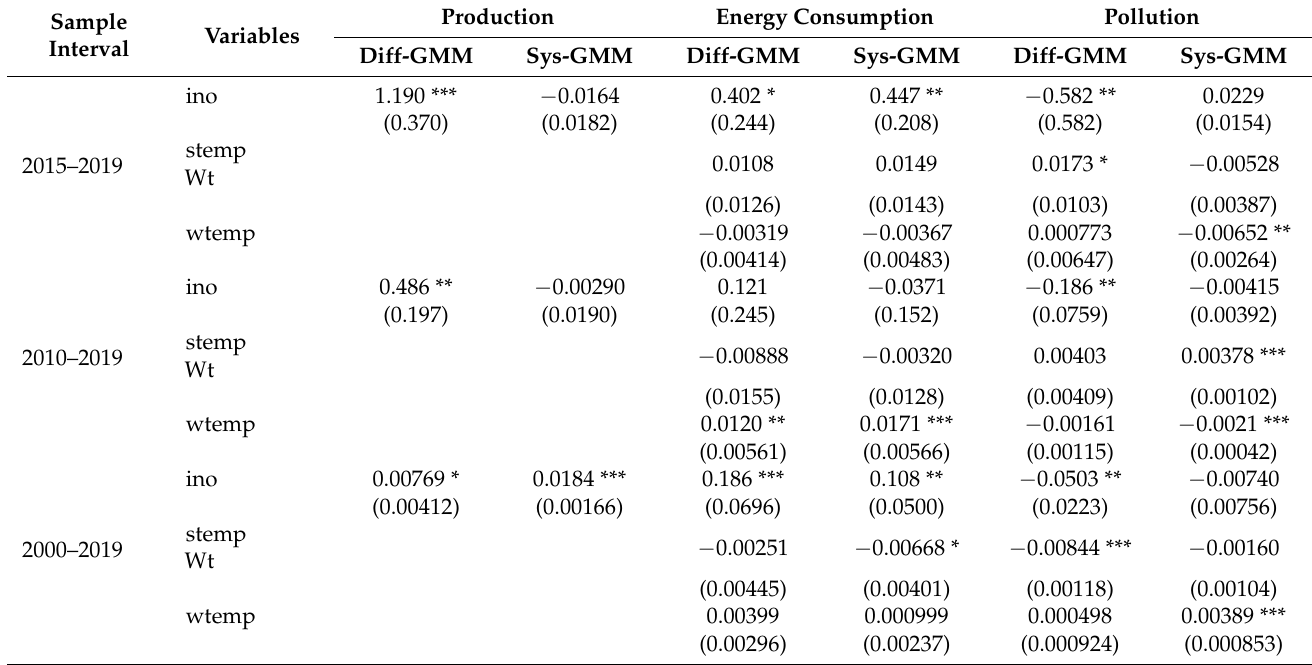
Table 10. Differences of sample interval (OECD).